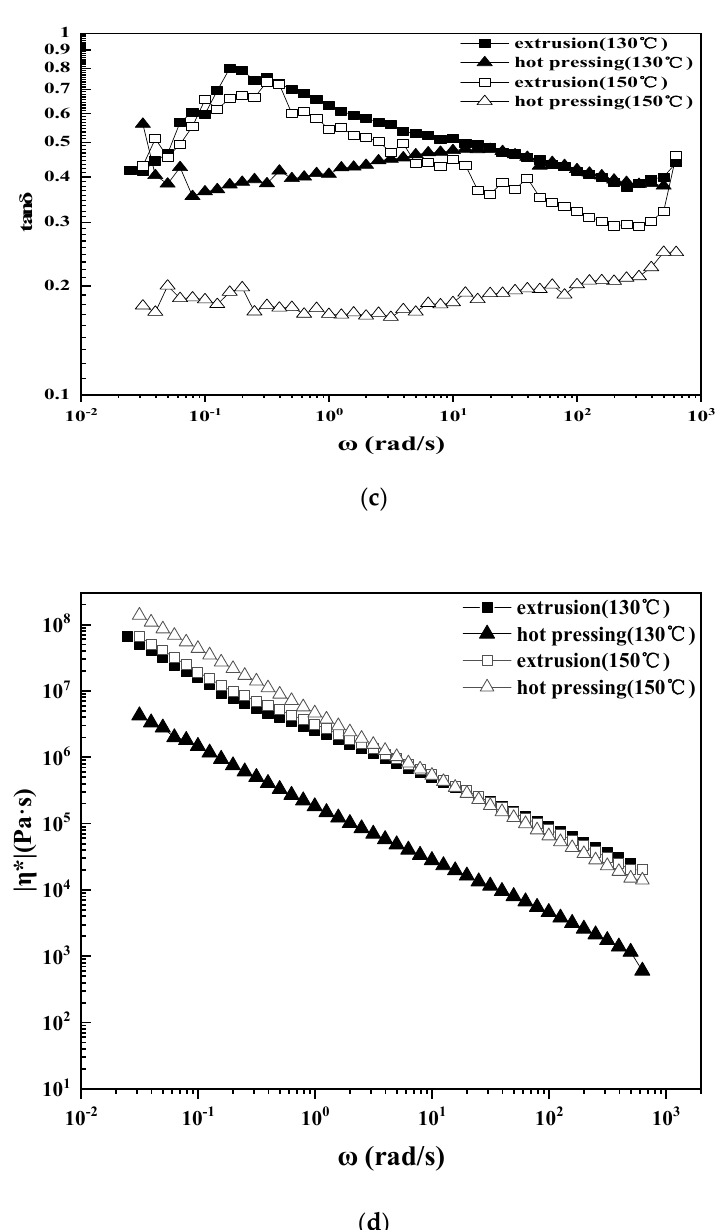
Figure 10. Plots of the storage modulus ( a ), loss modulus ( b ), loss tangent value ( c ) and complex viscosity ( d ) vs ω of straw/LLDPE composite.